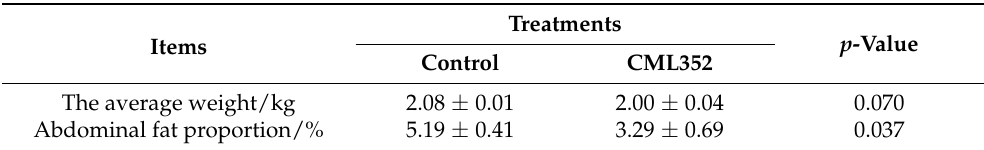
Table 9. Effects of dietary supplementation with L. salivarius on weight and abdominal fat deposition of laying hens.